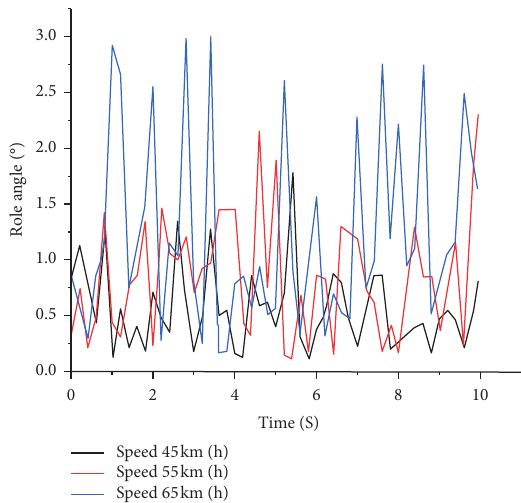
Figure 10: Roll angle change of the accelerated lane changing scenarios.